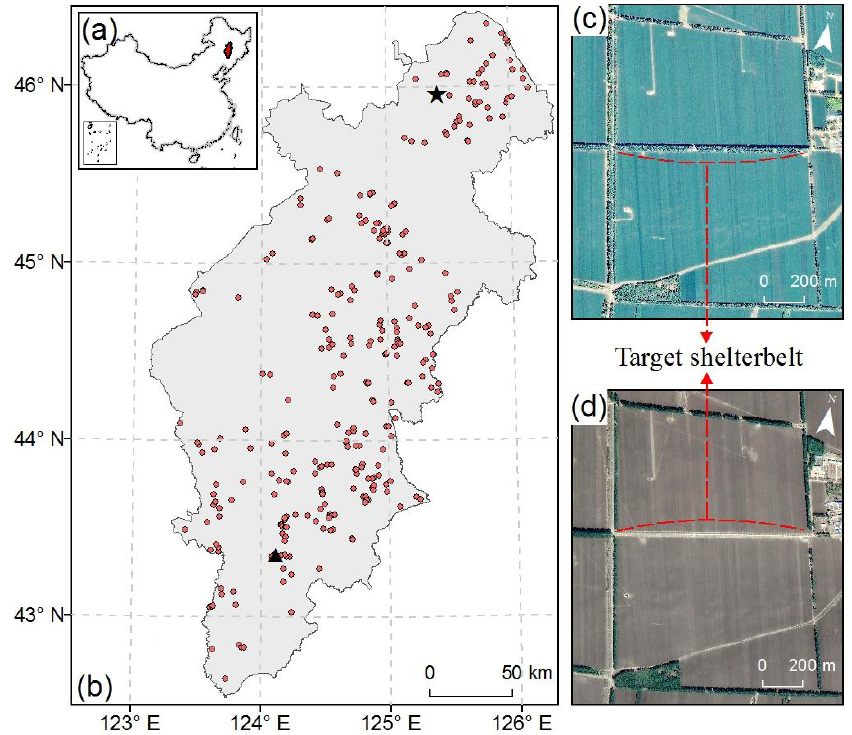
Figure 1. The location of the study area (in red) ( a ) and the spatial distribution of target shelterbelts ( b ). Subplots ( c ) and ( d ) show an overview of a target shelterbelt (star in ( b )) via Google Earth images before (Imagery Date: 18 July 2015) and after cutting (Imagery Date: 9 May 2018). The triangle in ( b ) represents the location of the field measurement.